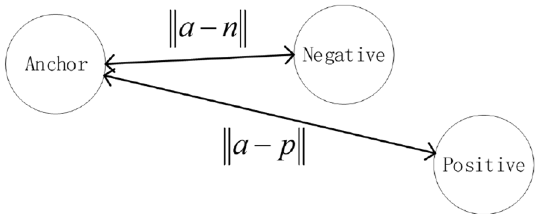
Figure 5. Hard triplets.